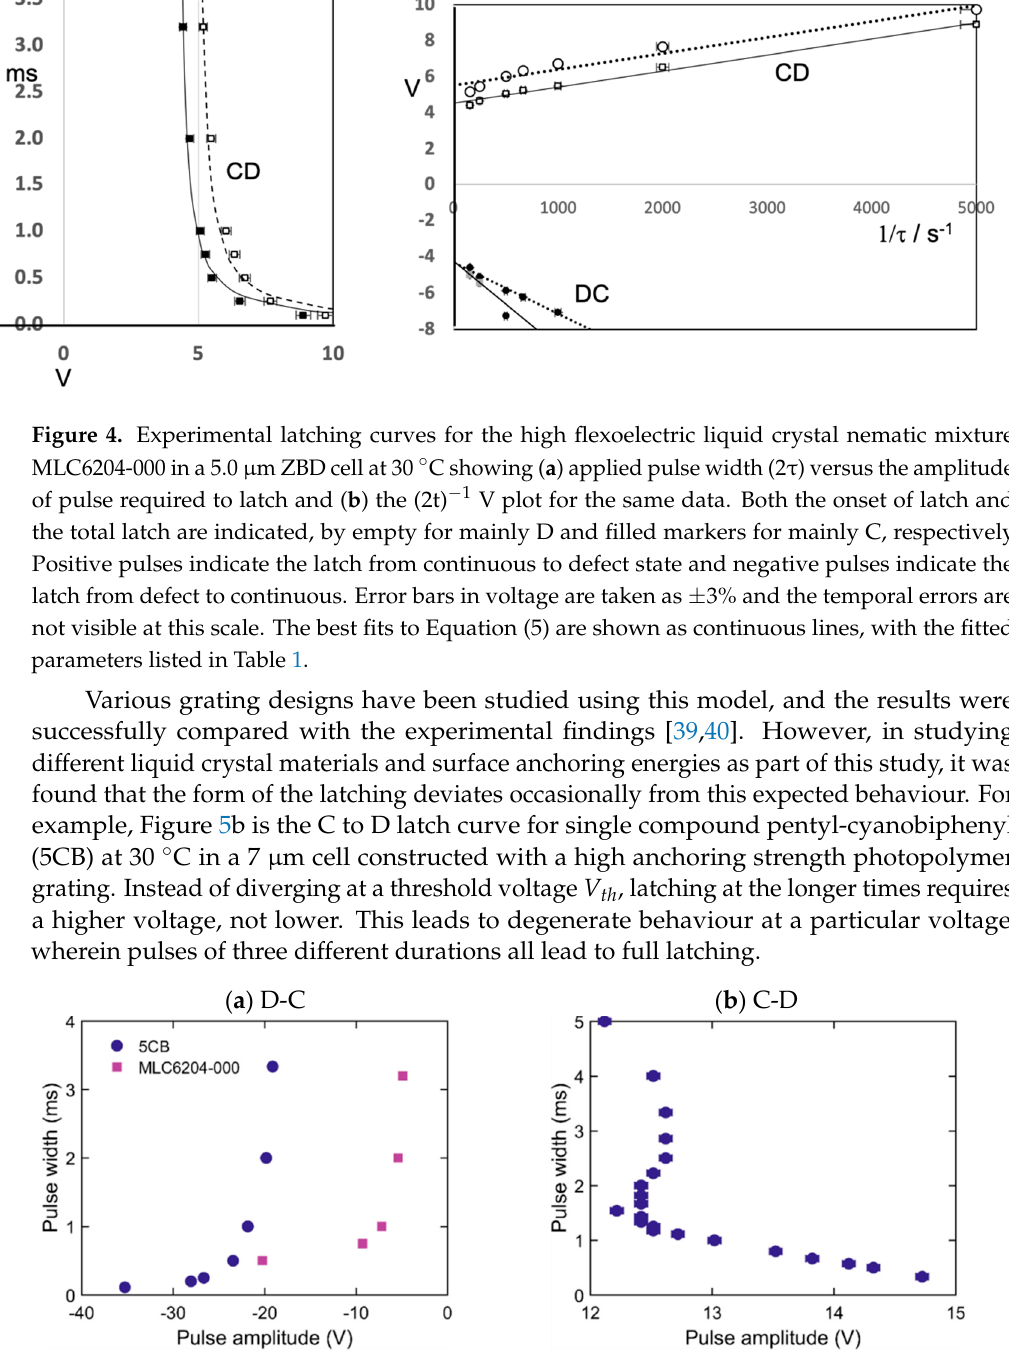
Figure 5. Experimental 𝜏𝑉 of the ( a ) defect to continuous state (D-C) latching and ( b ) continuous to defect state (C-D) latching for the compound 5CB in a 7 μ m ZBD cell (HAN mode) at 30 °C. Strong anchoring of 2.4 ± 0.5 × 10 − 4 N/m was obtained using the method of reference [27]. Markers indicate the threshold for a full latching. Error bars indicate the uncertainty in the pulse amplitude for latch. Also shown in magenta are the results for D-C latching for MLC6204-000 for comparison.